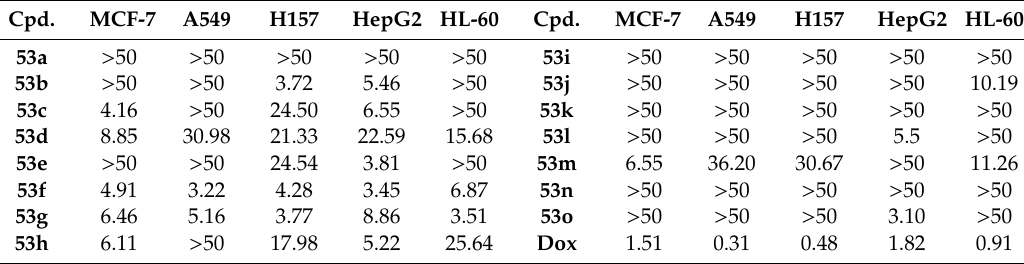
Table 5. In vitro antiproliferative activity of compounds 53a–o as IC 50 ( µ M) [31].